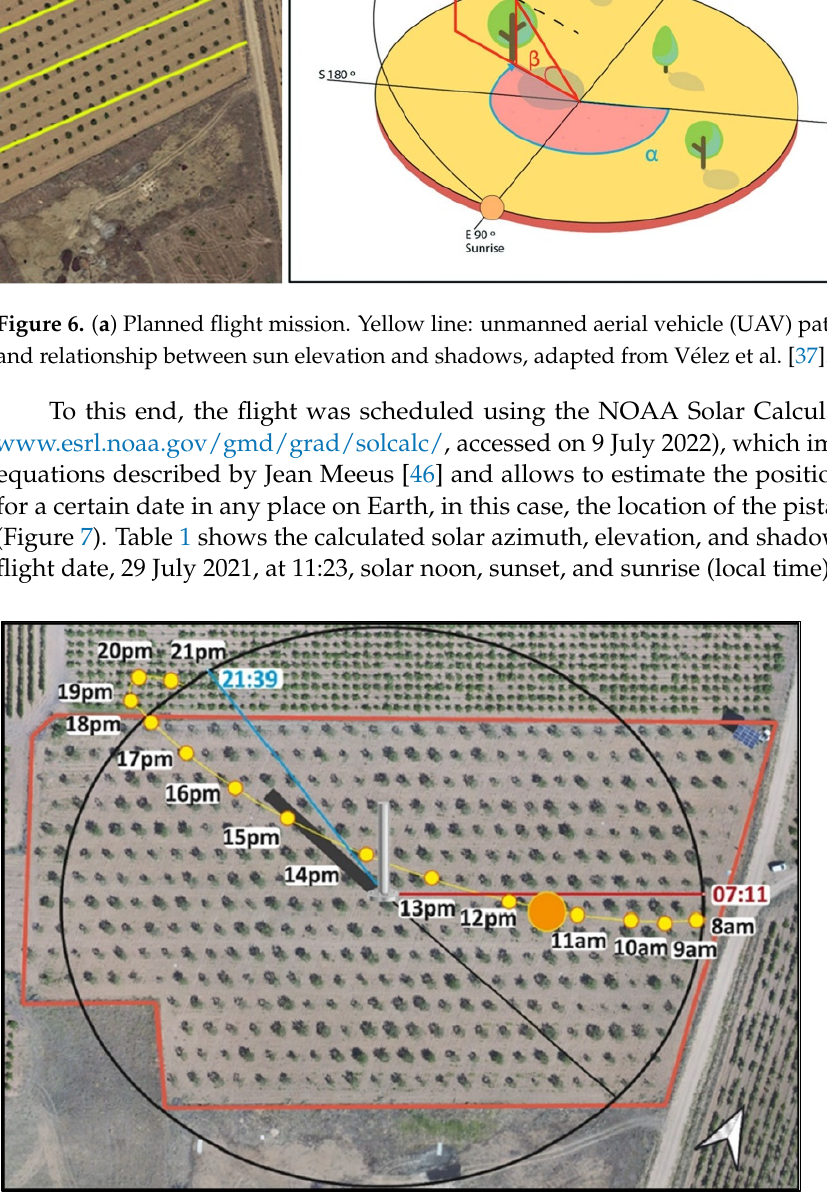
Figure 7. Position of the sun throughout the day at the experimental site. Red polygon: UAV flight area.